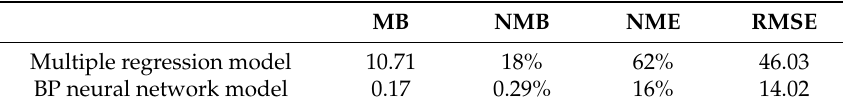
Table 2. Model evaluation.